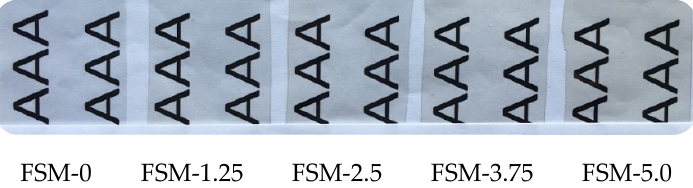
Figure 2. Composite edible film sample with different MAA concentrations.